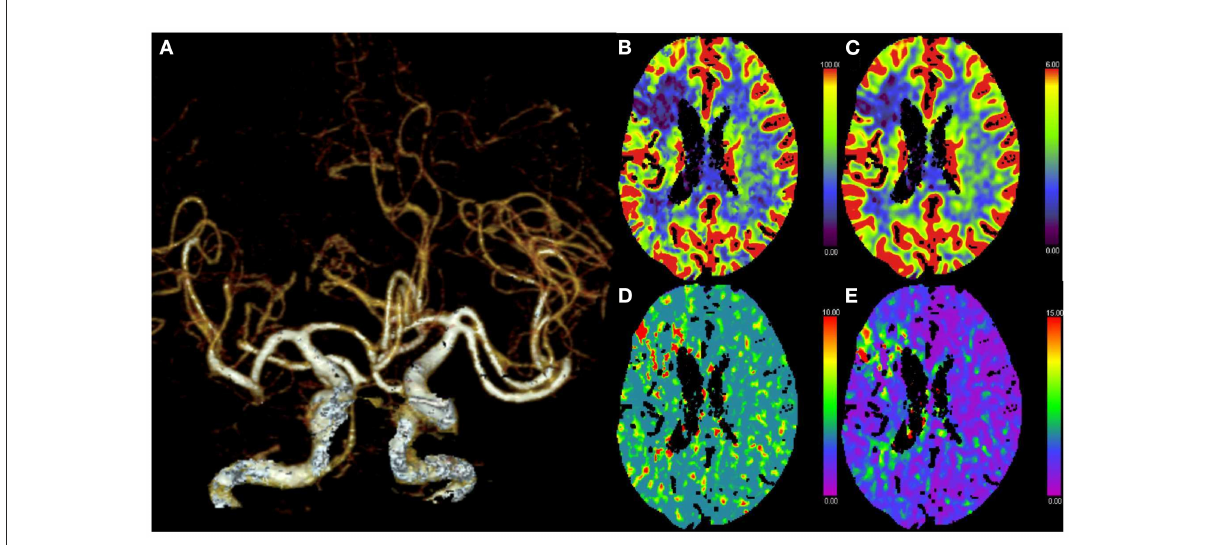
FIGURE3 Post-treatment CT angiography (CTA) and perfusion (CTP) at 5 days. (A) CTA demonstrates no occlusion of the ACA and DMCA. (B–E) CTP shows normalization of perfusion in the left cerebral